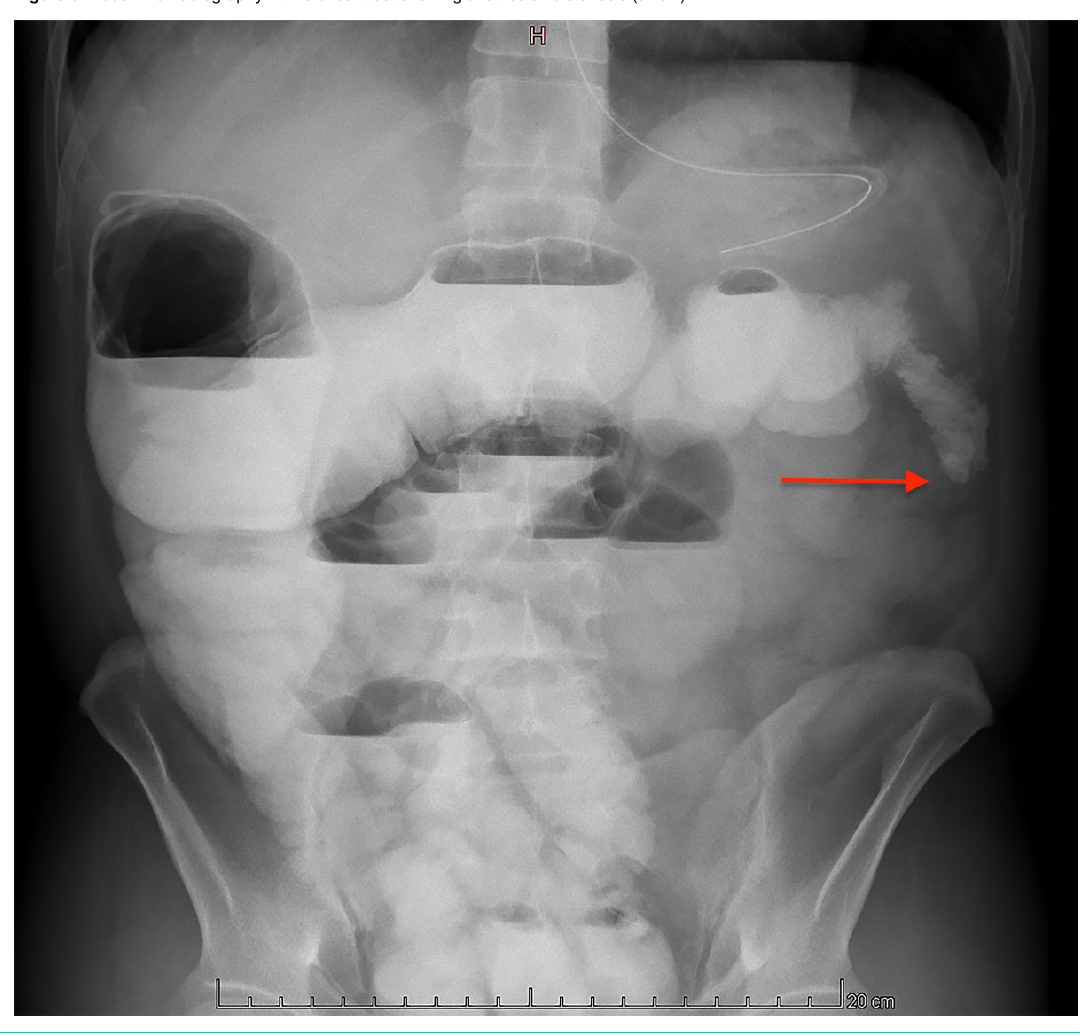
Figure 5: Abdominal radiography with oral contrast showing a left colonic stenosis